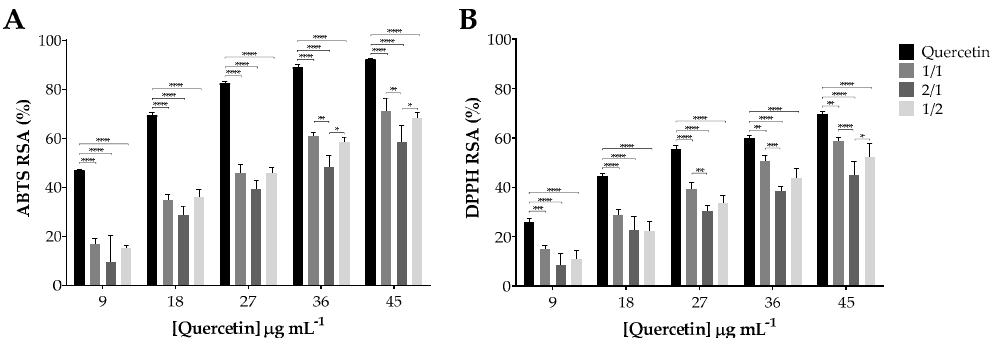
Figure 6. Antioxidant activity of quercetin incorporated within SA-PVA hydrogels. ( A ) ABTS and ( B ) DPPH radical scavenging activity percentage of free quercetin and quercetin-loaded SA-PVA hydrogels. Data points correspond to mean ± standard deviation for n = 3 replicates; * p < 0.05, ** p < 0.01, *** p < 0.001, **** p < 0.0001.